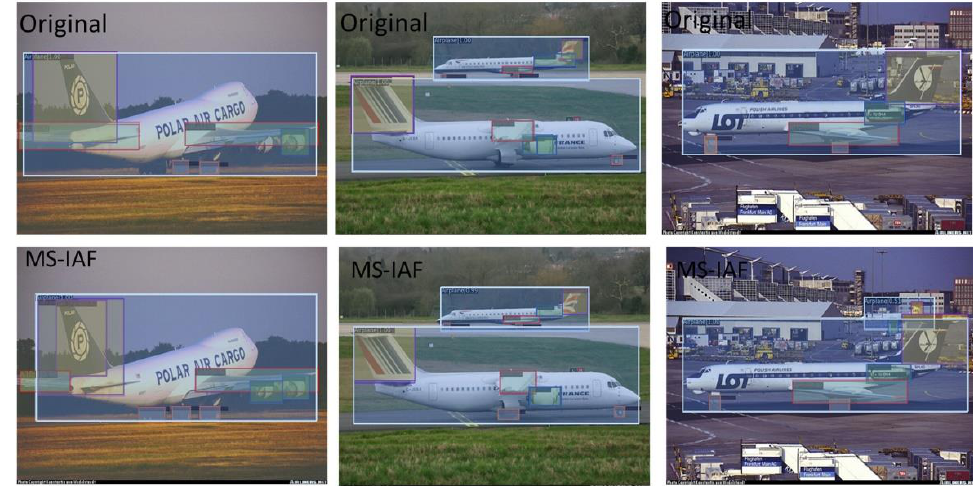
Figure 8. Comparison of test results on AP-DATA dataset.